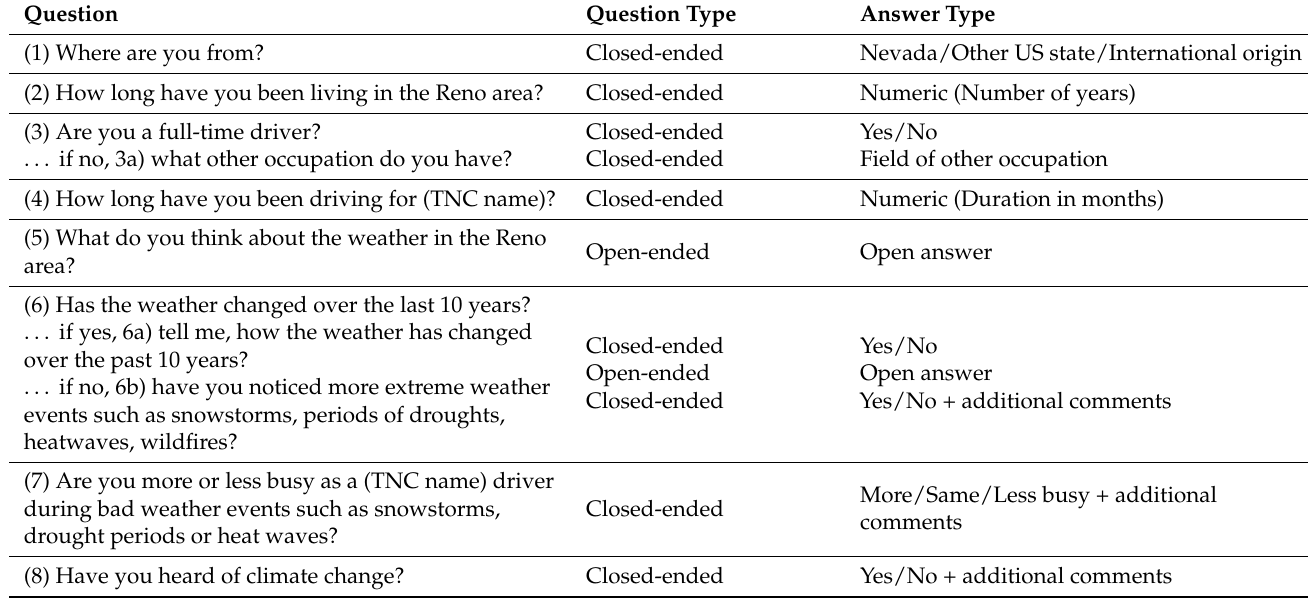
Figure A1. Correlation of age and climate change belief categories of participants driving for TNCs (Transportation Network Companies). Each dot represents one participant. * One participant with belief category climate change caused by humans refused to answer their age and was, therefore, excluded for the age-belief category correlation. Table A1. Questionnaire for survey on the climate change perceptions of TNC (Transportation Network Company) drivers for this study. Questionnaire was designed for a short interview during TNC rides.